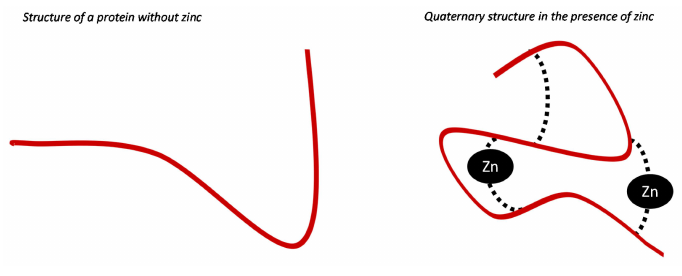
Figure 1. Zinc role in stabilizing protein quaternary structure